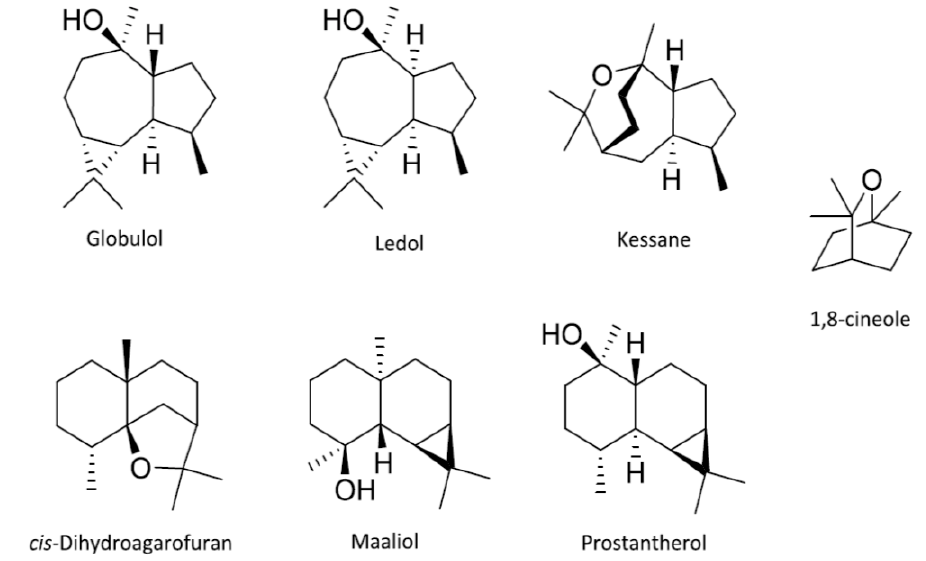
Figure 1. 1,8-cineole and key sesquiterpenes in Prostanthera .